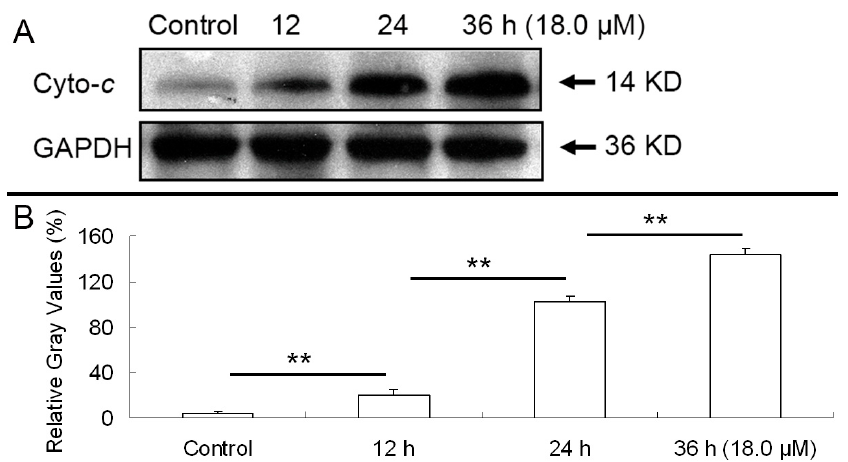
Figure 5. Exposure to DEFL1 resulted in release of cytochrome c . ( A ) Western blotting results of cytochrome c after various time of treatment; ( B ) Relative gray values of western blotting results were determined by Image J. ** p < 0.01.